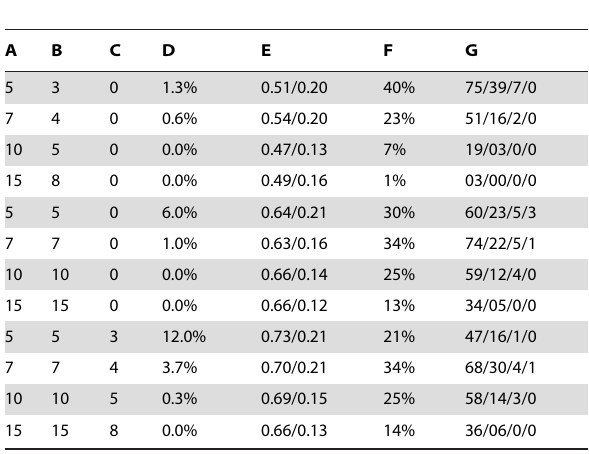
Table 1. Performance of reverse-engineering for varying network sizes and experimental